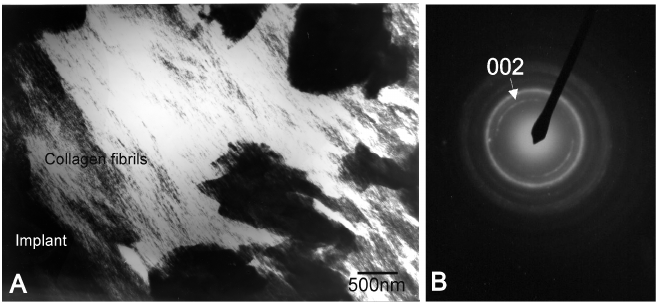
Figure 7. ( A ) Stained interface in a transmission electron micrograph on day 60, where well-resolved collagen fibers are observed in the newly-formed Ca-P phase; ( B ) equivalent selected area diffraction pattern of new bone tissue; thin unstained section.